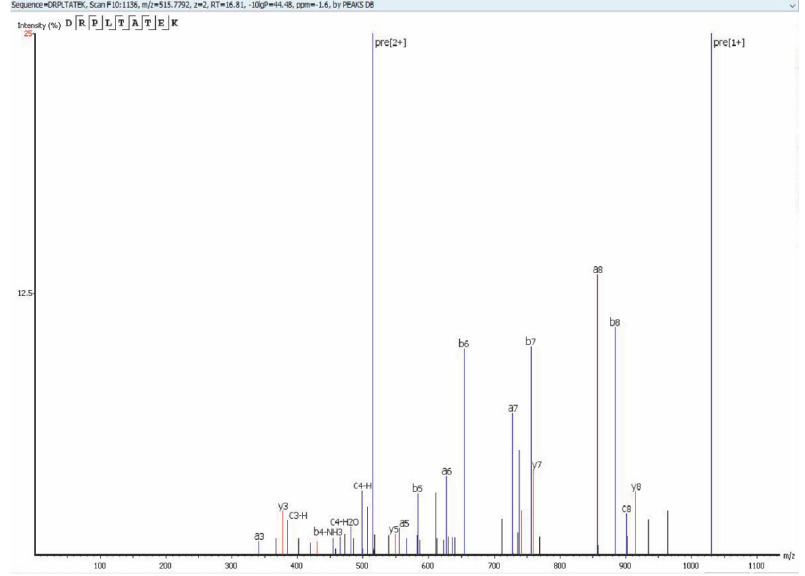
Figure 3. CID spectrum of the precursor ion at m/z7792 (z = 2) corresponding to the peptide sequence (DRPLTATEK) of an ORF52 (–10lgP 0f 44.48 and –1.6ppm), from F10:1136 detected by using the Bruker Impact II UHR-QqTOF 125 LC/MS system identified with PEAKS Studio software.